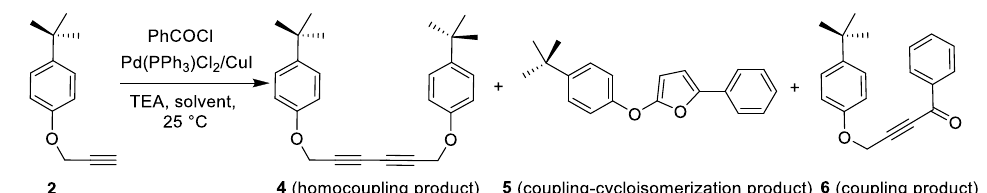
Table 1. Optimization of the cross-coupling of propargyl ether 2 with